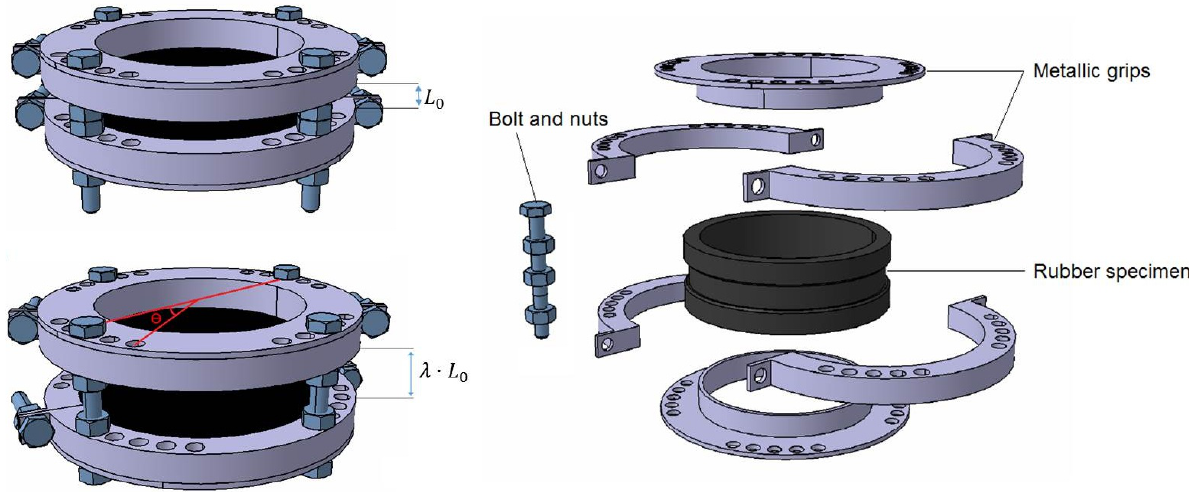
Figure 3. Specially-designed device for the immersion test of rubber specimens in the presence of multiaxial mechanical